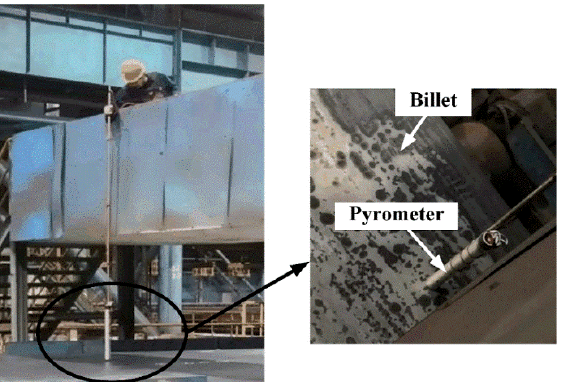
Figure 11. Photo of application of the pyrometer in medium plate rolling process.